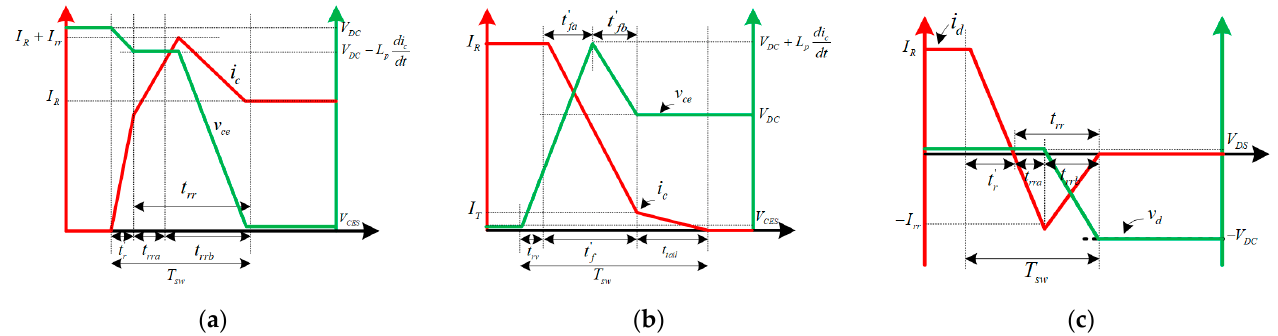
Figure 5. Linear piecewise approximation of the switch behavior. ( a ) IGBT turn on, ( b ) IGBT turn off, ( c ) diode turn off.